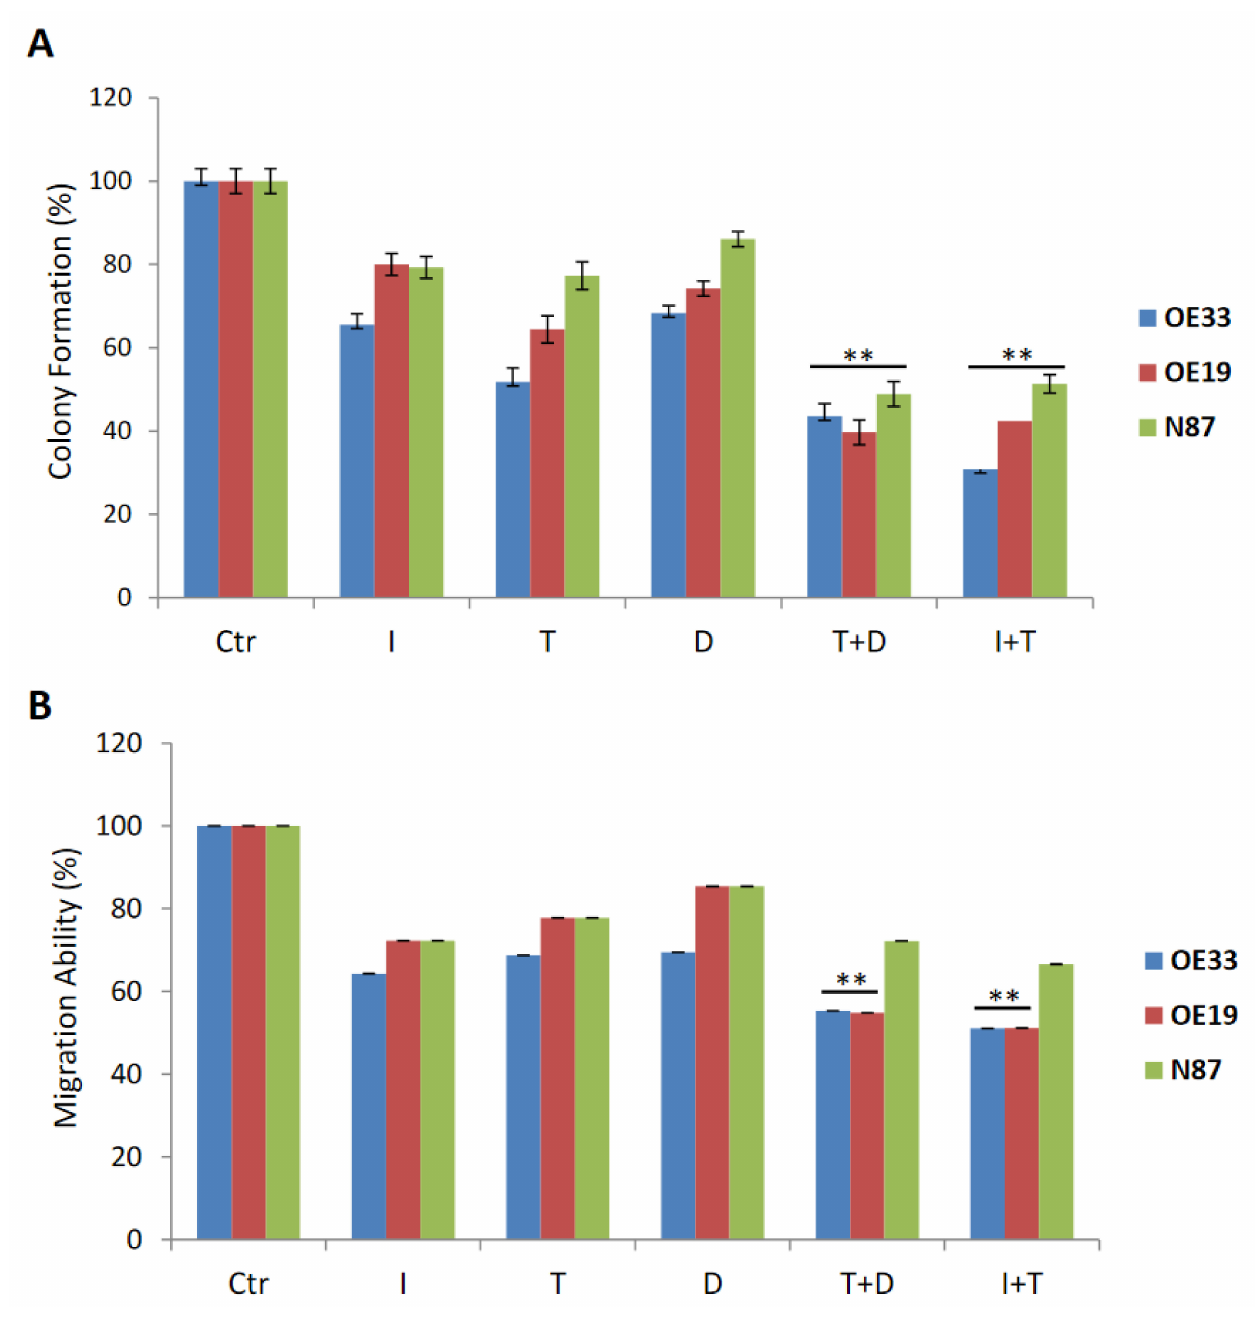
Figure 3. Effecton colonyformation ( A ) and migrationability ( B ) of Trastuzumab, Ipatasertiband Duligotuzmabtreat- ment, assingle agent and in combination, in human gastriccancercelllines: OE33, OE19 and N87. (C: untreatedcontrol, T: Trastuzumab, D: Duligotuzumab, I: Ipatasertib, Trastuzumabwith Duligotuzumab, T+D; Ipatasertibwith Trastuzumab, I+T). Eachassaywasperformedasdescribedin Materialsand Methods, afterthe indicatedtreatmentsatIC50 doses. The re- sultsare the average ± SD of threeindependentexperiments, eachdonein triplicate. Asterisksindicate statisticalsignificance (** p ≤